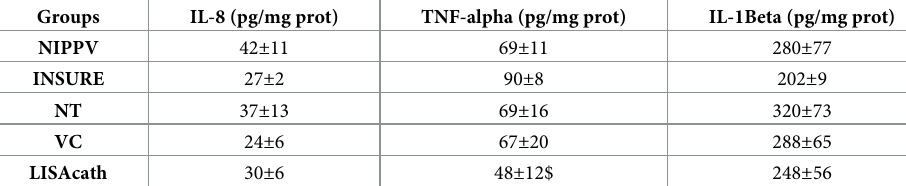
Table 2. Biochemical lung analysis. Groups